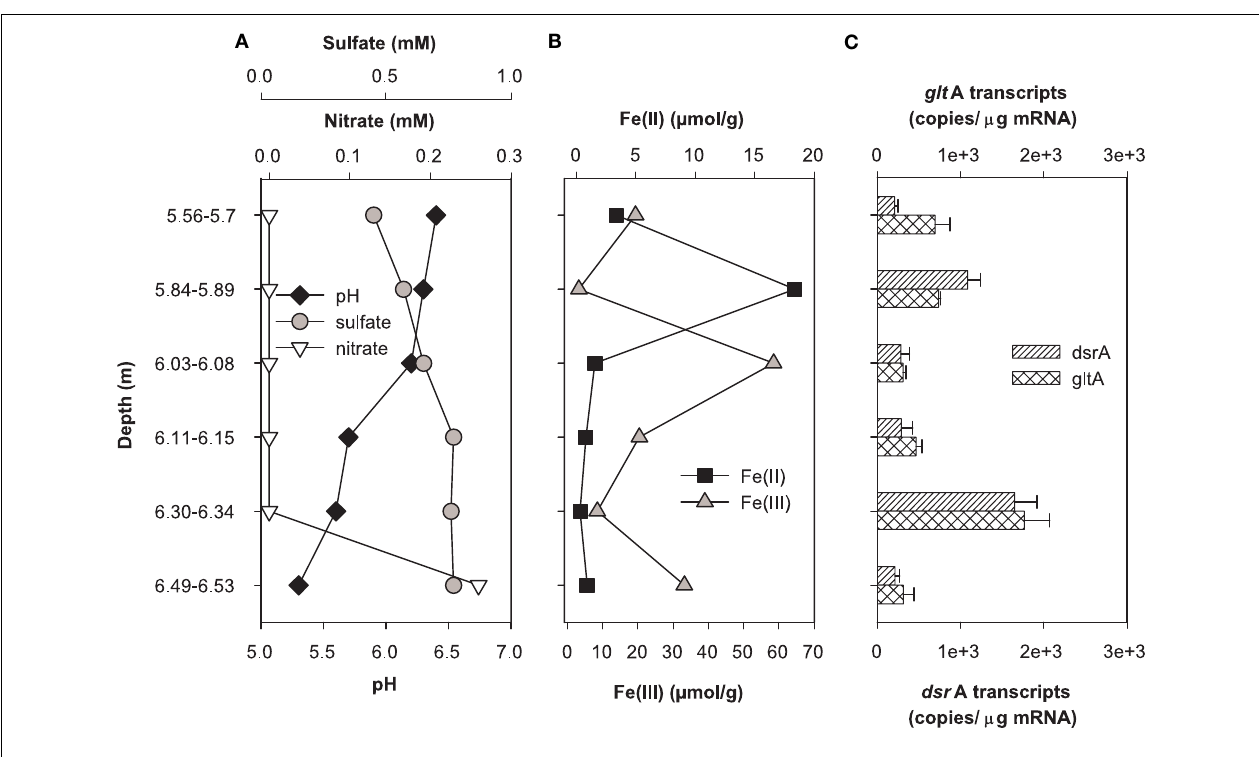
determinations on a pooled sample from triplicate borehole sediment samples. Nitrate, sulfate, pH, and iron data were reported previously as supplemental material in Green et al. (2010). Uranium was not